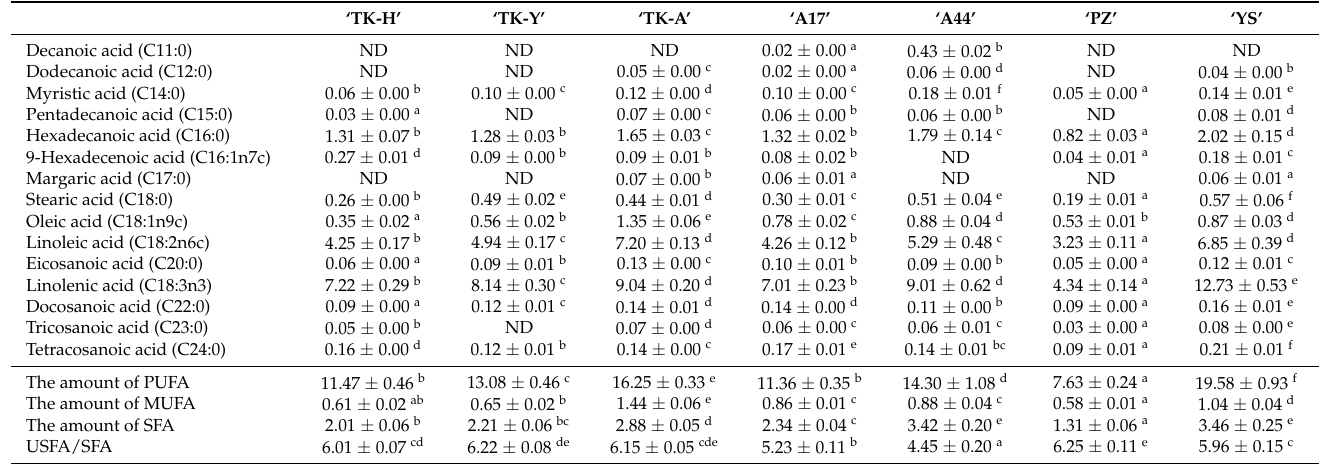
Table 1. Fatty acid contents (mg/g DW) in dandelion